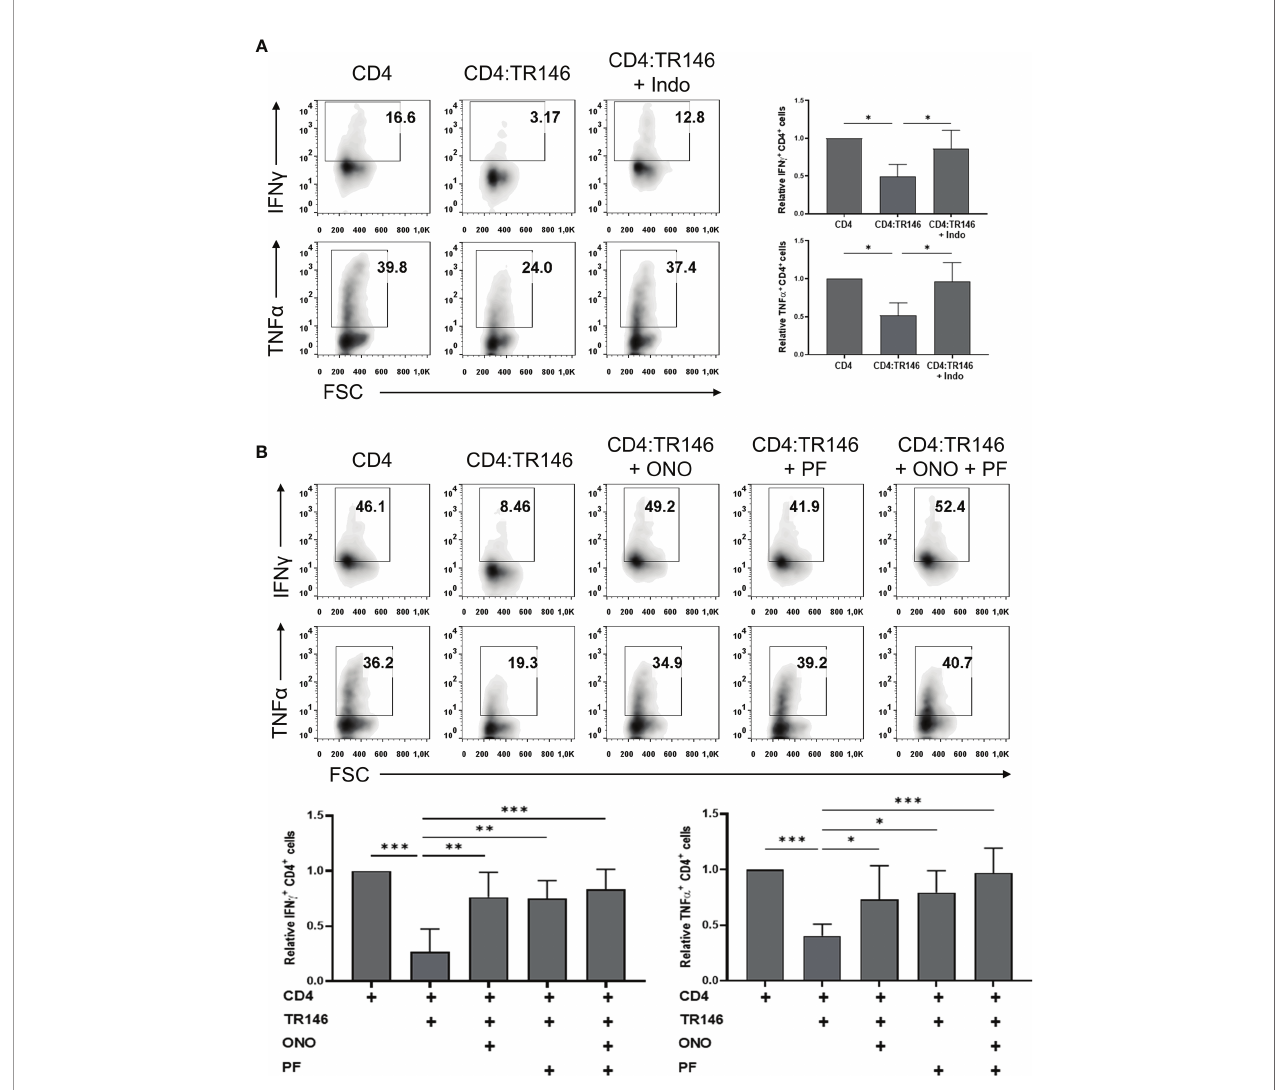
FIGURE 4 | TR146 cells suppress CD4 T cells via PGE2 release. (A) TR146 cells were treated or not with 2 m g/mL indomethacin (Indo) for 4 hours and co-cultured with anti-CD3/CD28-activated CD4 T cells for 4 hours. (B) CD4 T cells were treated with PF-04418948 (PF) and/or ONO-AE3-208 (ONO) inhibitors for 1 hour, activated with anti-CD3/CD28 beads and co-cultured with TR146 cells for 4 hours. All data were obtained by fl ow cytometry analysis and shown as the percentage of IFN g and TNF a -producing CD4 T cells from representative experiments (density plots) and relative to CD4 T cells alone when considering all experiments (bar graphs). FACS gatings were adjusted by the use of mouse anti-IgG-PE and anti-IgG-APC antibodies. Bar graphs display mean values with SEM error bars. Statistically signi fi cant differences were obtained applying ANOVA tests. Signi fi cant differences (p < 0.05, p < 0.01 and p < 0.001) are noted as “ * ” , “ ** ” and “ *** ” , respectively. Data were obtained from a total of four independent experiments using samples from different